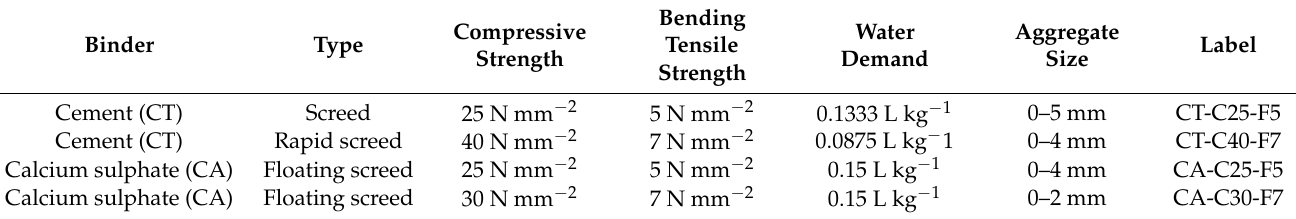
Table 1. Classification of the used cement-based and calcium sulphate based screed